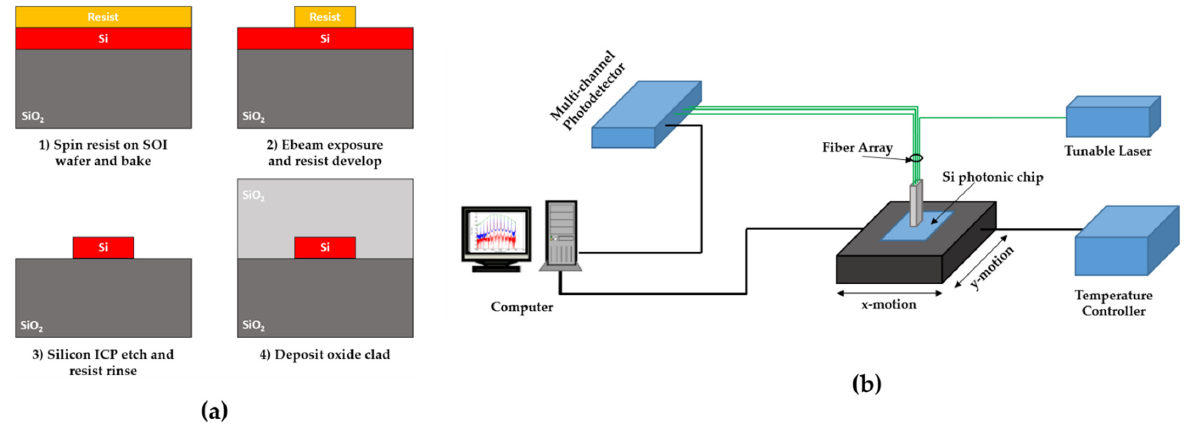
Figure 6. ( a ) Silicon waveguide fabrication steps using EBL; ( b ) schematic of the measurement setup. The layout of the fabricated LT-MZI and SEM images of its various components are shown in Figure 7a. The measured transmission spectra of the LT-MZIs with L = 50 µm and L = 150 µm are shown in Figure 7b,c, respectively, along with the corresponding IN- TERCONNECT simulation results. It can be seen that there is a good match in the device response between the simulation and the measurement results. The FSR calculated from the measurements was 11.24 nm and 4.19 nm with 1.1% and 2.18% deviation from the simulation results for the 50 µm and 150 µm devices, respectively. These results further ensured that the numerical simulation results we obtained previously could be trusted.